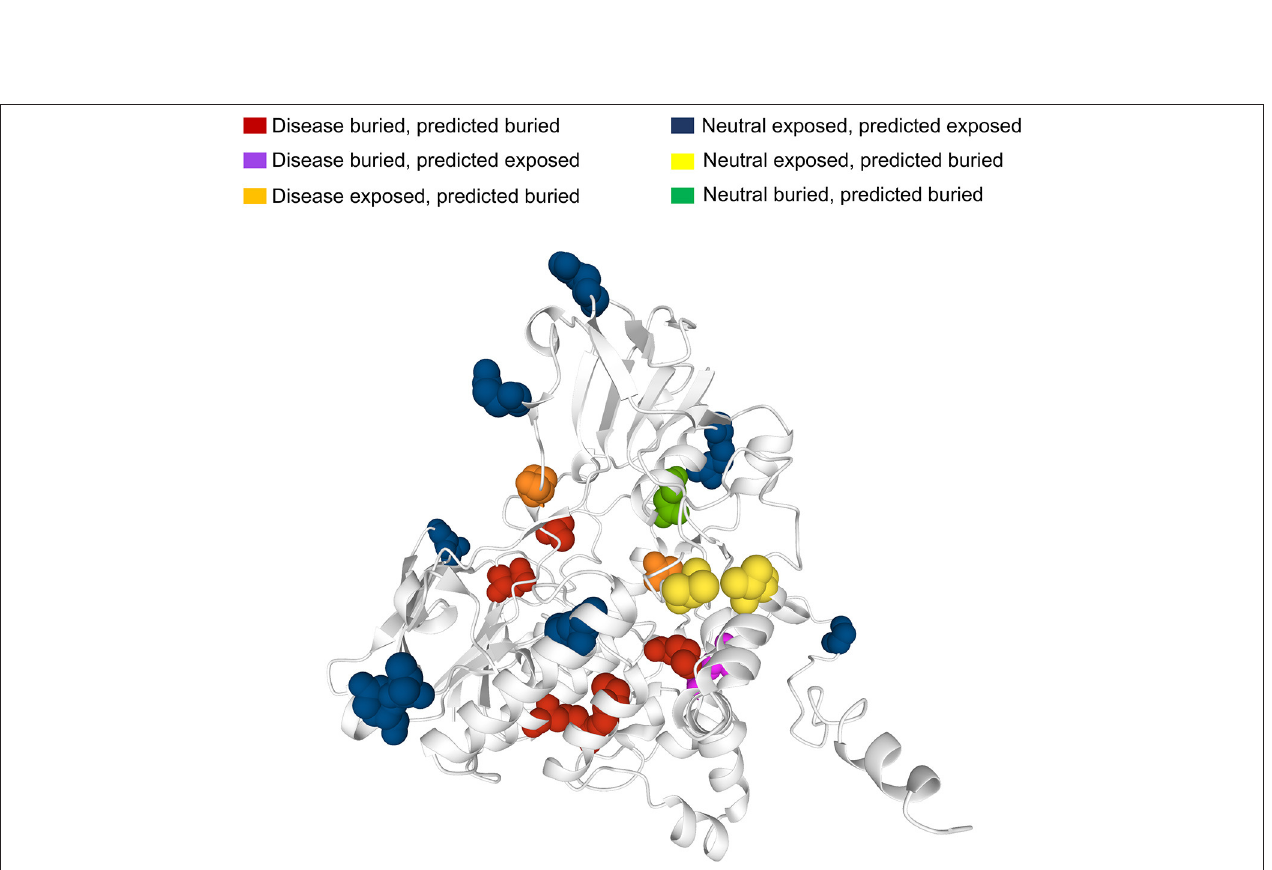
FIGURE 6 | Mapping SASA predictions on a protein model. The model is that of human Dimethylaniline monooxygenase 3 (UniProtKB: P31513) derived from the SWISS-MODEL Repository. Solvent exposure is computed from the available 3D protein model using DSSP. Variation (SVR) positions are highlighted using the spacefill view. In red, buried positions associated to disease-related SRVs and correctly predicted as buried by our method. In magenta, buried disease-related positions wrongly predicted as exposed. In orange, exposed disease-related positions wrongly predicted as buried. In blue, exposed neutral SRV positions correctly predicted as exposed. In yellow, exposed neutral positions wrongly predicted as buried. In green, buried neutral positions correctly predicted as buried.